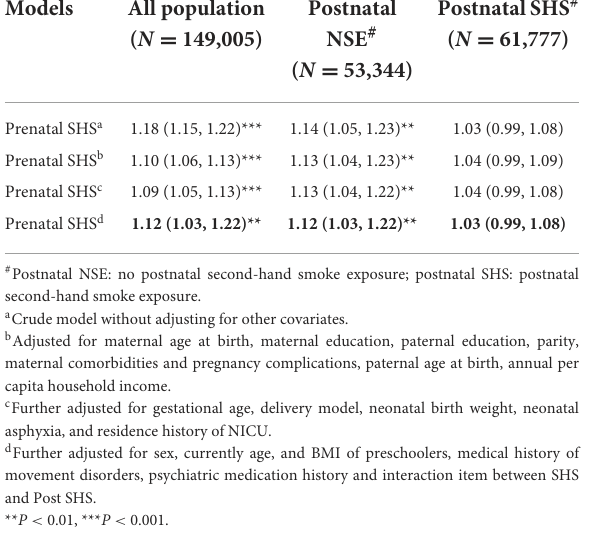
TABLE 4 Association of prenatal SHS exposure with risk of suspected DCD ( N = 149,005, ORs/AORs, 95% CI).